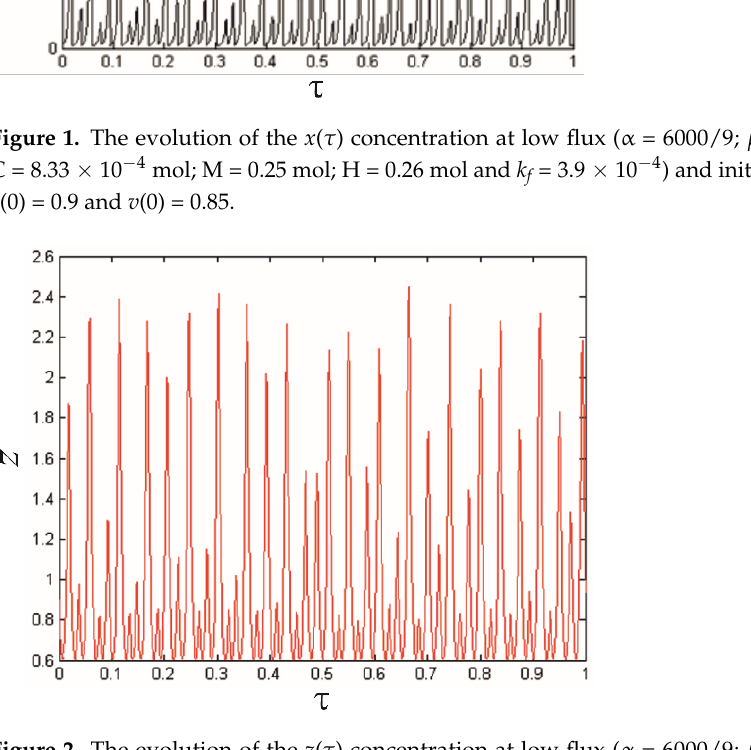
Figure 2. The evolution of the z ( τ ) concentration at low flux ( α = 6000/9; β = 8/23; A = 0.1 mol; C = 8.33 × 10 − 4 mol; M = 0.25 mol; H = 0.26 mol and kf = 3.9 × 10 − 4 ) and initial values: x (0) = 0.045, z (0) = 0.9 and v (0) =